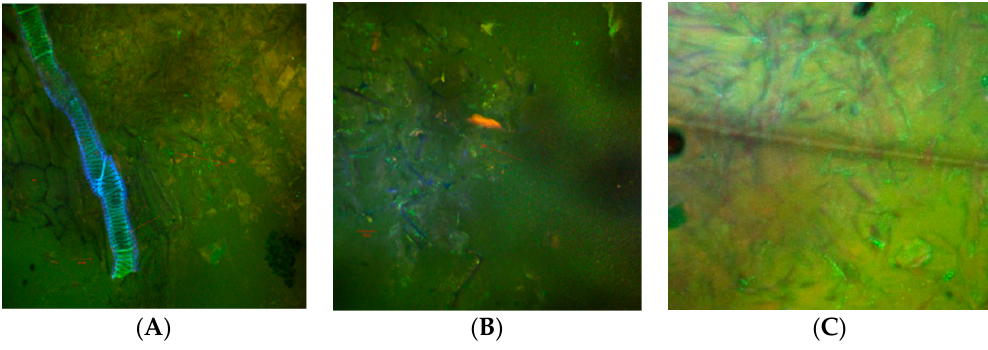
Figure 3. CLSM images of samples microstructure: ( A )—fresh cubes with LAB; ( B )—dried chips with LAB; ( C )—freeze dried powder with LAB ( Lb. plantarum BL3 viable cells—in green and the non-viable bacteria in red).